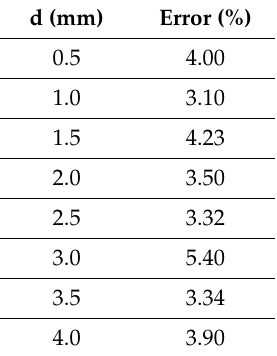
Figure 11. Results of repeated measured. Table 4. Measurement Table 3. Measurement error.